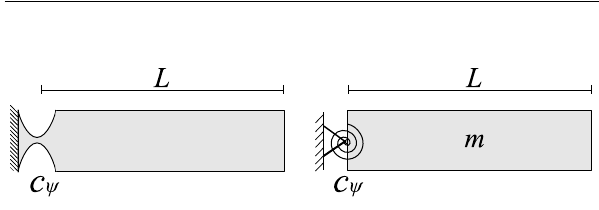
Fig. 5. Continuous flexure hinge (left) and equivalent discrete tor- Figure 5. Continuous flexure hinge (left) and equivalent discrete sion spring model (right) torsion spring model